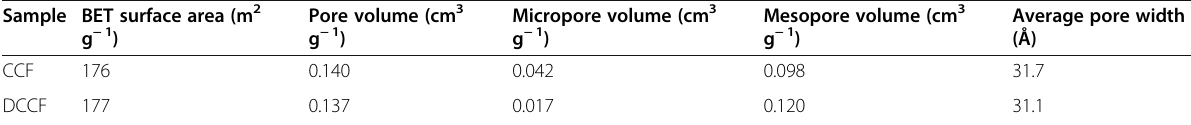
Table 1 Surface area characteristics from BET